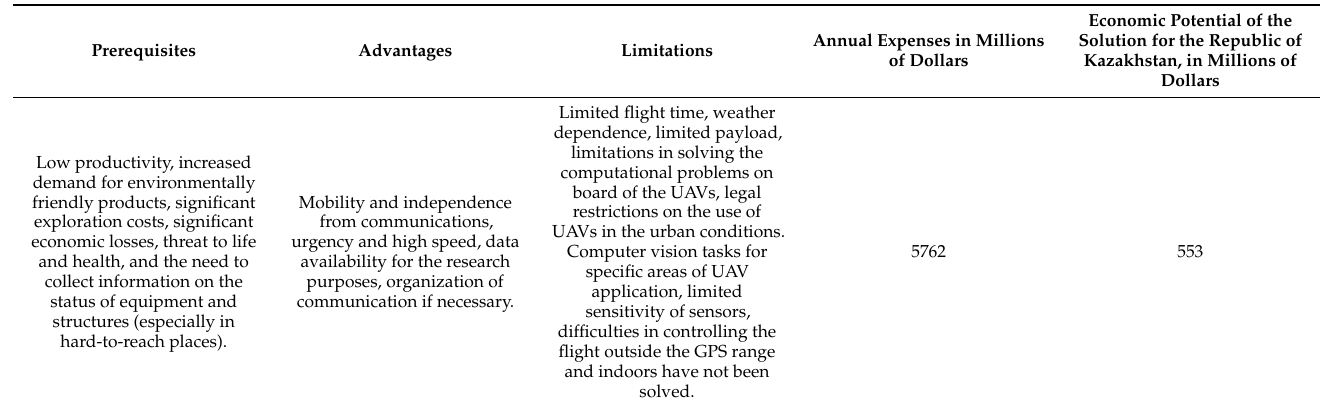
Table 5. Advantages and limitations of